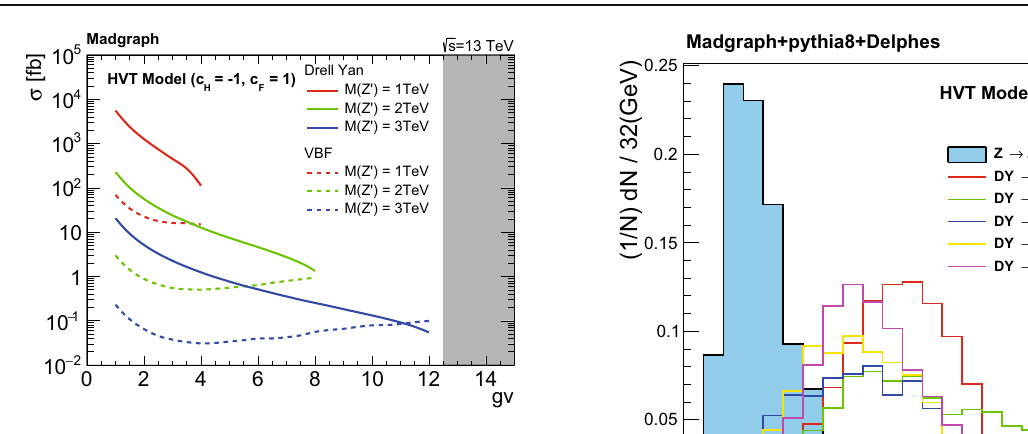
Fig. 7 Exotic Higgs → b ¯ b transverse momentum, p ⊥ , originating from heavy vector resonances, compared with SM Higgs p ⊥ . Exotic Higgs bosons are typically of higher p ⊥ ( p ⊥ > 150